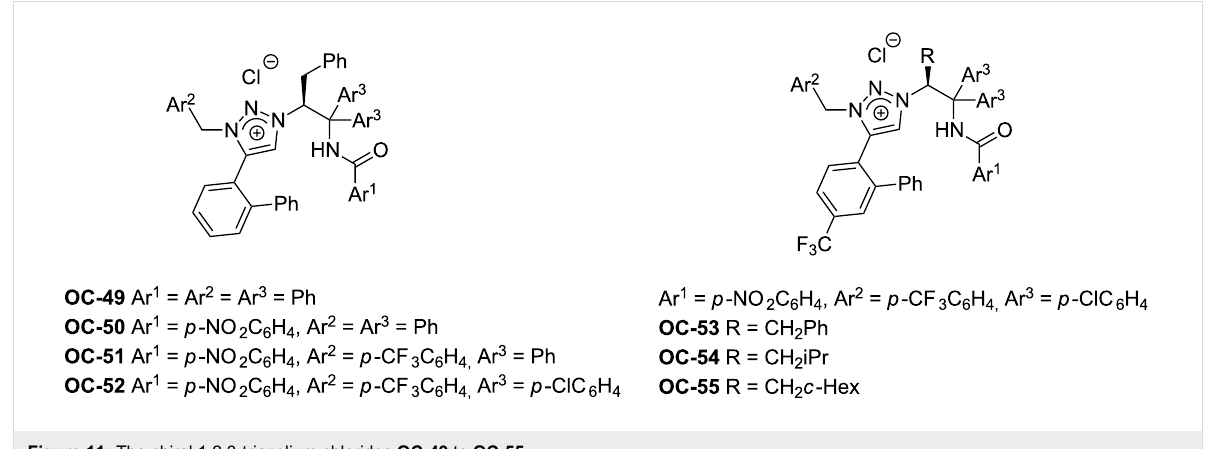
Figure 11: The chiral 1,2,3-triazolium chlorides OC-49 to OC-55 .